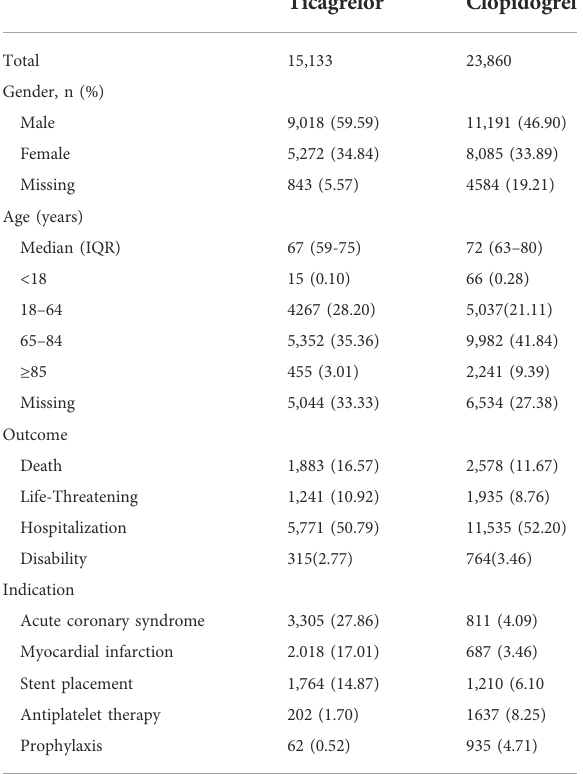
TABLE 2 ADE reports and clinical